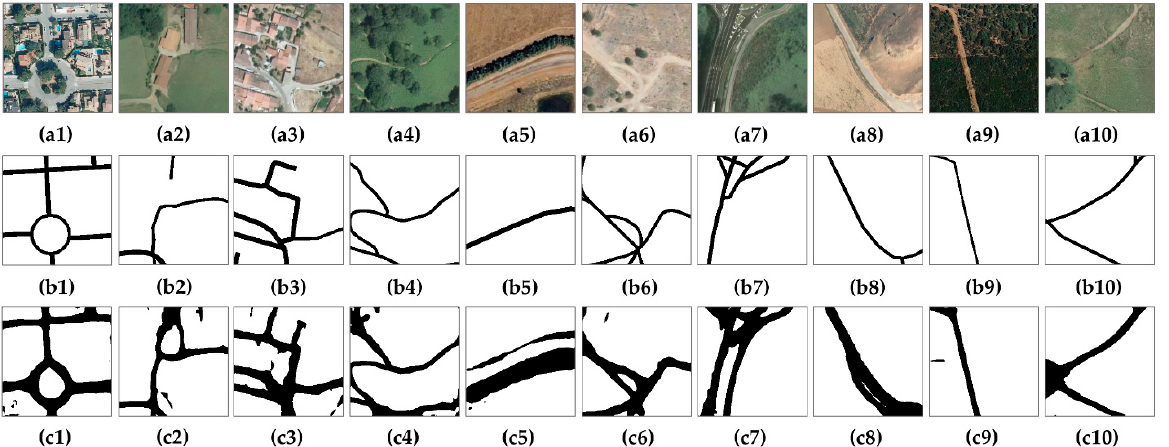
Figure 2. The relation between the aerial orthoimage (first row, ( a1 – a10 )), the rasterised segmentation mask (ground-truth or real sample, seen in the second row, ( b1 – b10 ) used as conditional information for training G ), and the semantic segmentation predictions (seen in the third row, ( c1 – c10 ), used for testing the performance of the model). Note: The training set contains n = 6784 tiles with road representation present in official cartography, while the test set contains n = 1696 tiles with initial segmentation predictions resulted from evaluating the aerial images with the segmentation model. In this figure, white is used to represent pixels labelled with “No road”, or “Background”, and black is used to represent the pixels belonging to “Road”